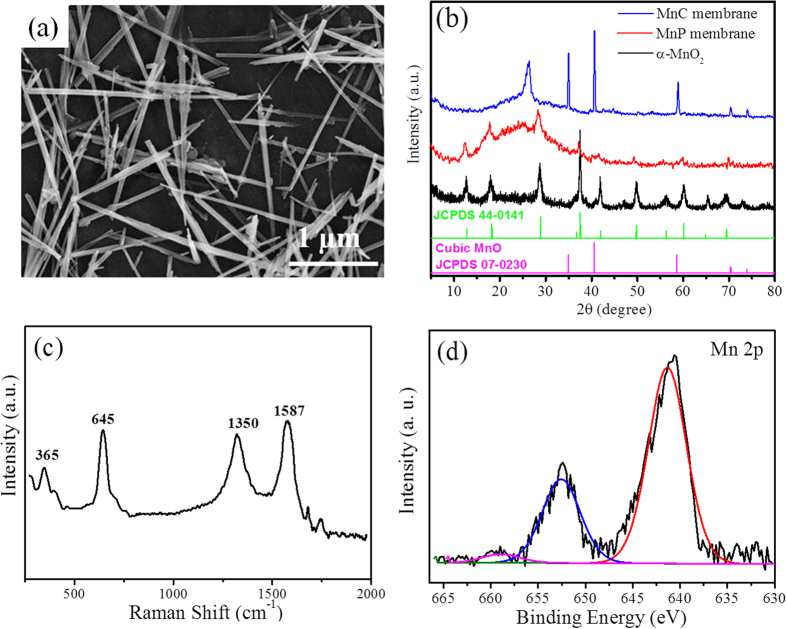
(a) SEM image of MnO2 NWs; (b) XRD patterns of MnO2 NWs and electrospun MnP, MnC membranes; (c) Raman spectra and (d) XPS Mn 2p spectra of MnC membrane.